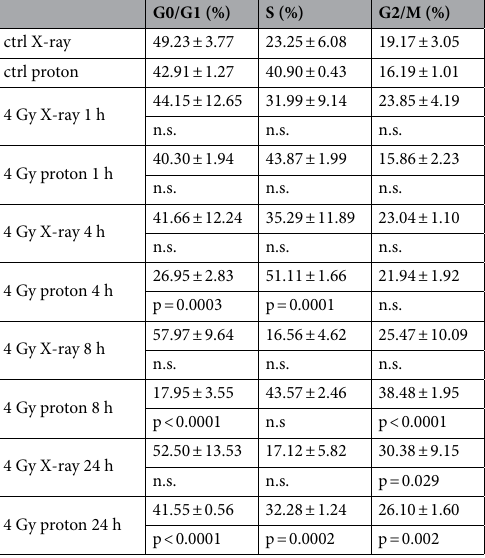
Table 1. Cell cycle distribution of chondrosarcoma cells 1 h, 4 h, 8 h, and 24 h after 4 Gy X-ray respectively proton IR (n = 5; mean ± SD; n.s. not significant).